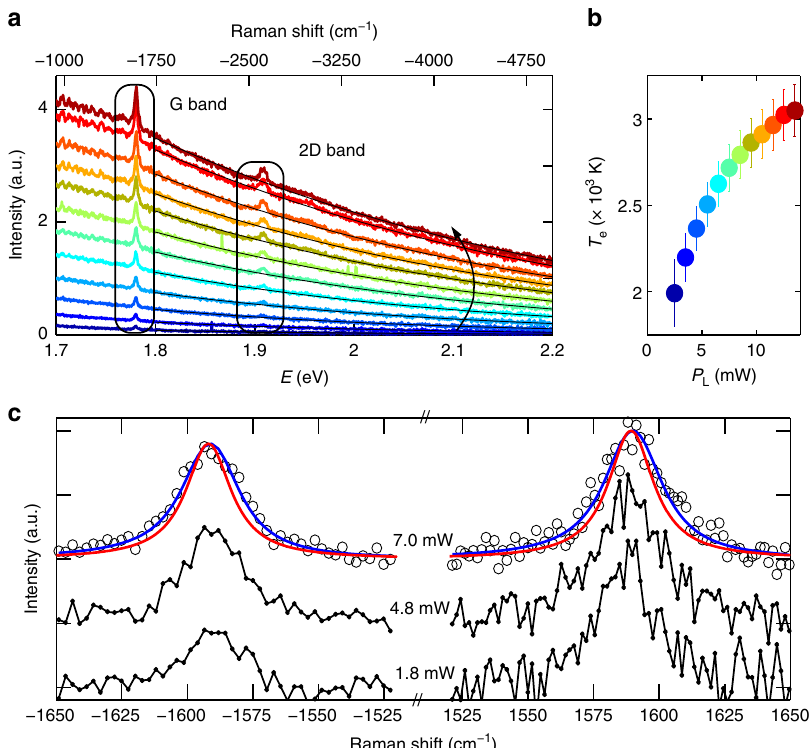
Fig. 1 Spectral response of SLG under ultrafast excitation. a AS Raman spectra under ultrafast excitation for laser powers increasing along the arrow direction. The P L -dependent background is fi tted by thermal emission (Eq. 1, black lines) resulting in T e in the 1700 – 3100K range. b T e as a function of P L . Error bars represent the 95% con fi dence bounds of the best fi t. c Background subtracted, AS and S G peak (in black, normalized to the corresponding S maximum) measured as function of P L in the range (cid:1) 1 : 8 (cid:3) 7 : 0 mW (corresponding to T e (cid:1) 2000 (cid:3) 2700K). Three representative P L values are shown. Best fi ts of the G peak (blue line), obtained as a convolution of a Lorentzian (red line) with the IRF are also reported for the largest P L